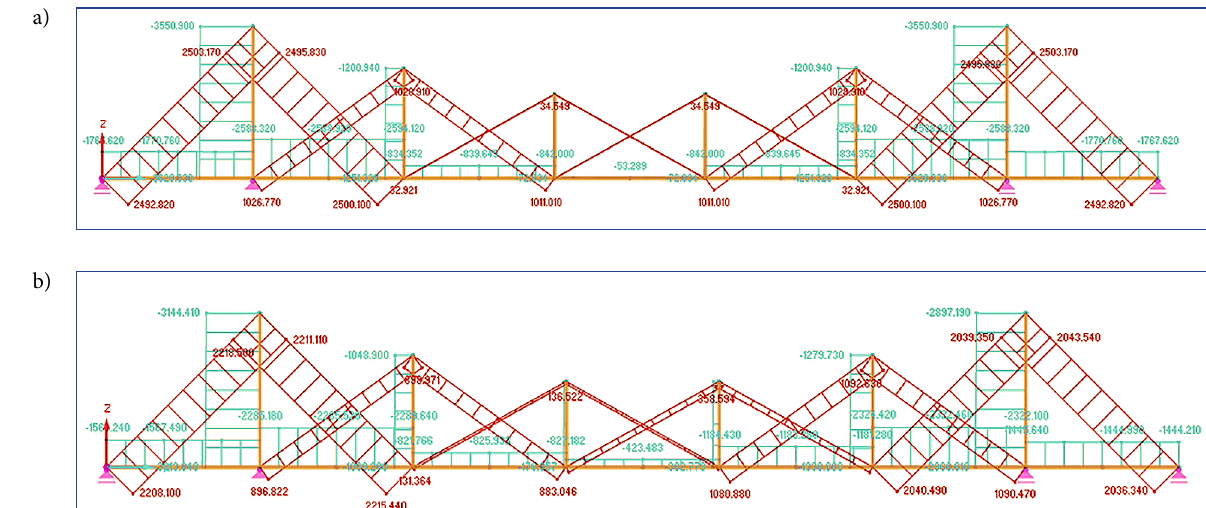
Figure 7. Varying pylons bridge. Bending moments: a) under symmetrical loading; b) under asymmetrical loading